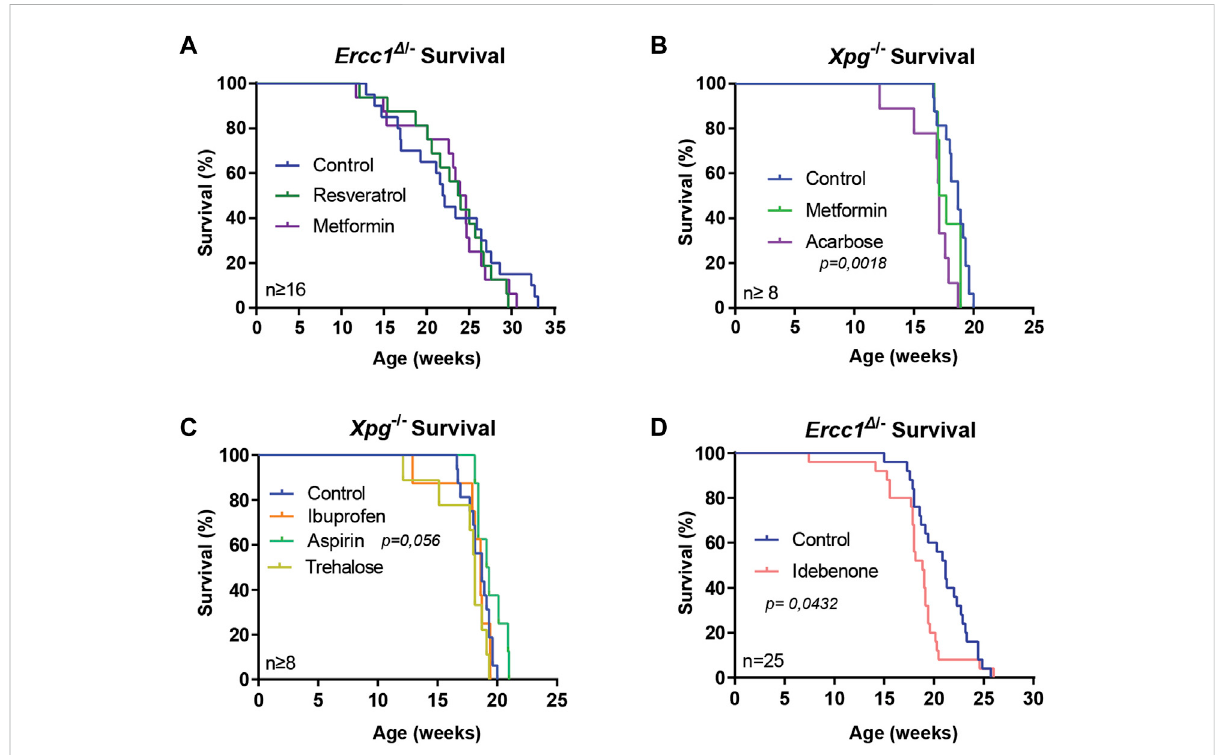
FIGURE 1 Supplementation of compounds for assessing lifespan changes of DNA repair-de fi cient mice. (A – D) , Survival curves of Ercc1 Δ / − mice on resveratrol, metformin (A) or idebenone (D) supplemented diet and Xpg − / − mice treated with metformin, acarbose (B) , aspirin or ibuprofen (C) . Indicated values are Mean (±SD). Signi fi cant p values of log-rank survival test (B,D) are